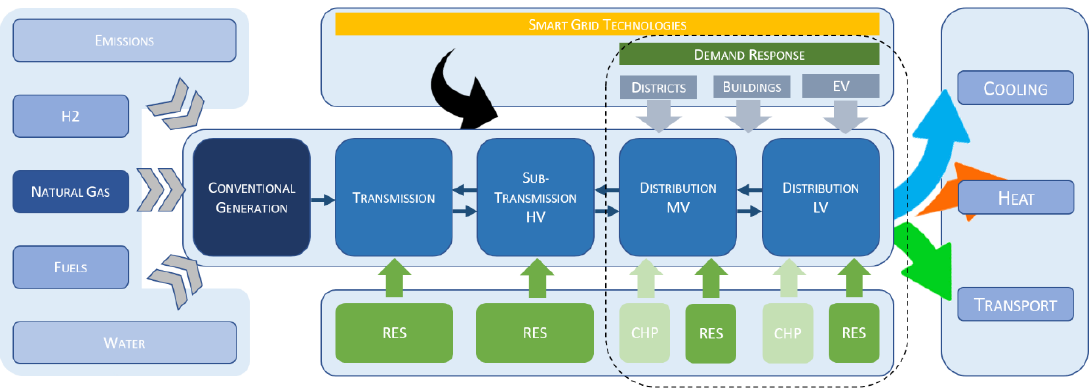
Figure 1. Linkages between the various energy carriers within a power system.